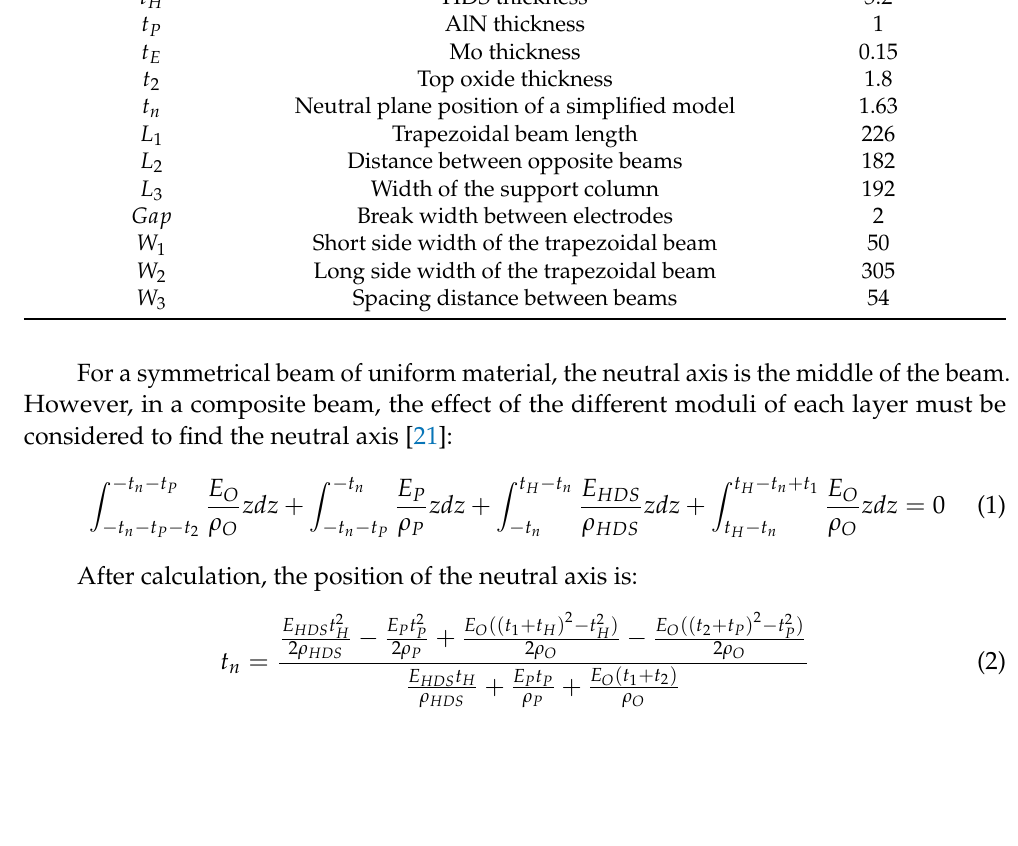
Table 1. Specific structural dimensions of Type A device.